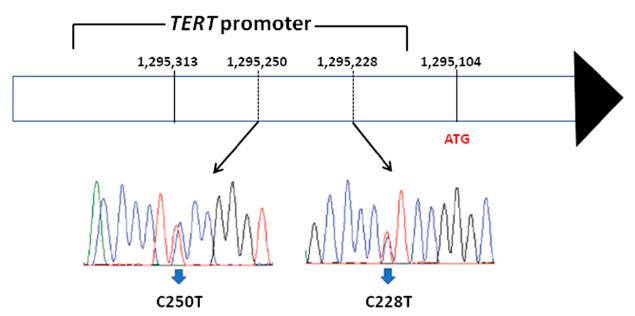
Figure 3. Schematic representation of TERT gene with the indication of the 2 most frequent mutations localized in the gene promoter, responsible for the transcription of the gene starting from the ATG codon.